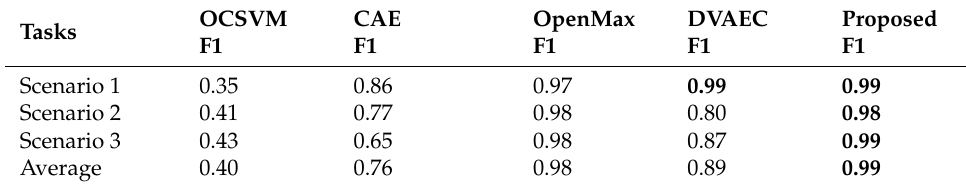
Table 11. Novelty detection performance of